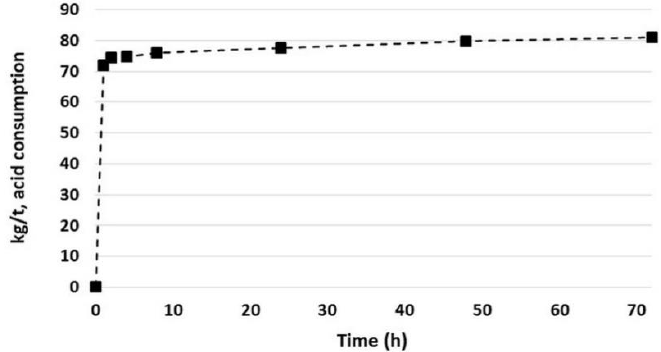
Figure 5. Sulfuric acid consumption rate under oxidizing conditions using O 3 . Solution potential controlled at 1000 mV and 25 °C and using 50 g/L H 2 SO 4 . Table 2. Chemical composition of the solid residue obtained from leaching with O 3.